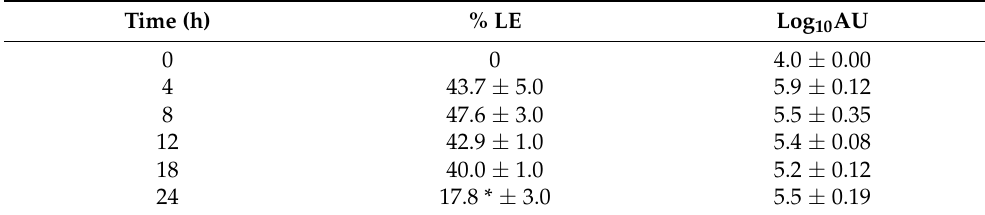
Table 2. The load efficiency (LE) of the nisin in bacterial cellulose by concentration of proteins compared to the nisin activity in different periods. Time (h) % LE Log 10 AU 0